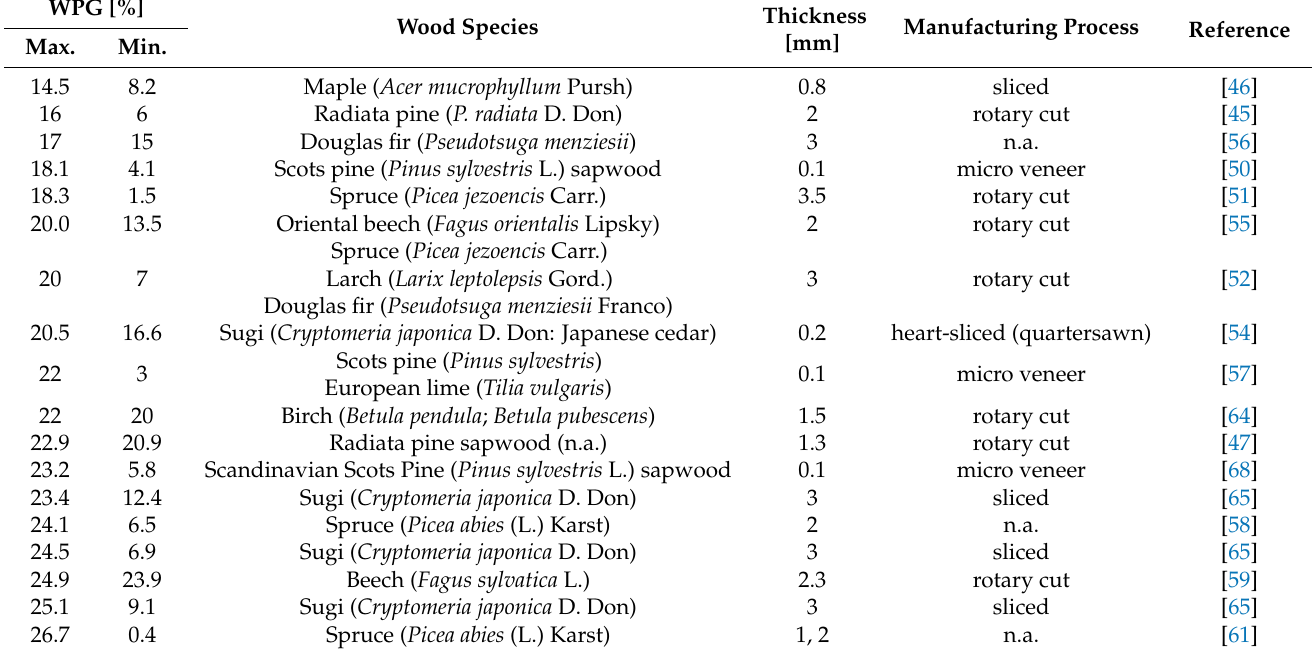
Table 1. The WPG ranked according to maximal values. Additional information is included, such as wood species, veneer thickness, and veneer manufacturing process (n.a. = no information available or not discovered). Yang et al. [65] compared thermal and microwave liquid phase and vapor phase